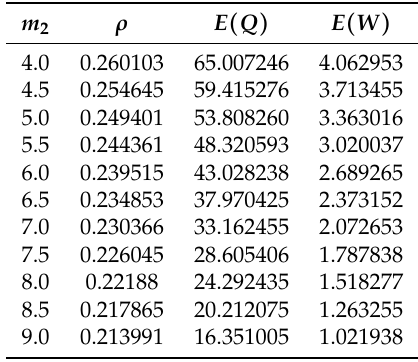
Table 3. Stand-by server’s service rate vs. expected queue length and expected waiting time for